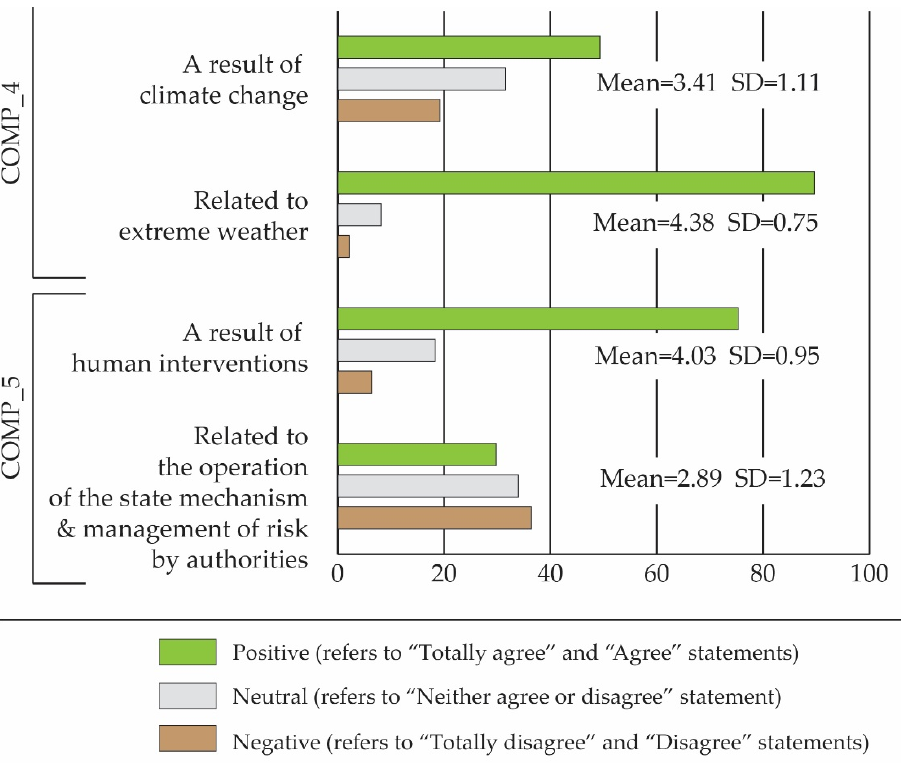
Figure 3. Descriptive data on the questions regarding the perceptions of the causes of the recent natural disasters in Greece. Table 7. Correlation analysis between risk perceptions of climate change, perceptions of personal effects of climate change and perceptions of the effects of climate change and the perceptions of the causes of the recent natural disasters in Greece. The Flood in Mandra (2017), the Wildfire in Mati (2018) and the Tornado in Halkidiki (2019),